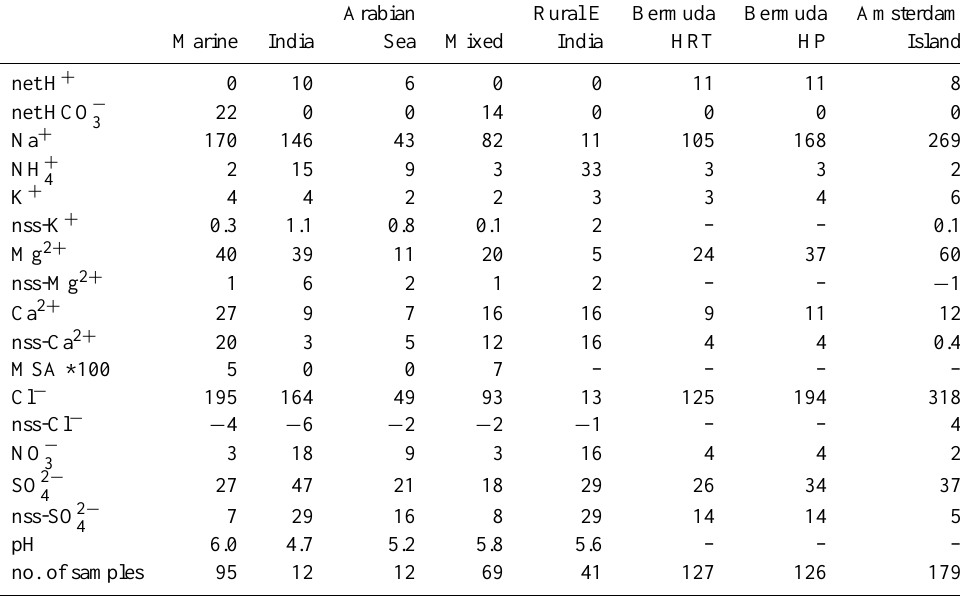
Table 1. Volume weighted mean concentrations in MCOH rainwater (this study) divided into trajectory groups and similar data for compari- son from four other locations: A rural site near Bhubaneswar in E India (data from continental trajectories) taken from Norman et al. (2001), two sites on Bermuda (Galloway et al., 1988) and Amsterdam Island (Moody et al., 1991). Unit: µeql − 1 .